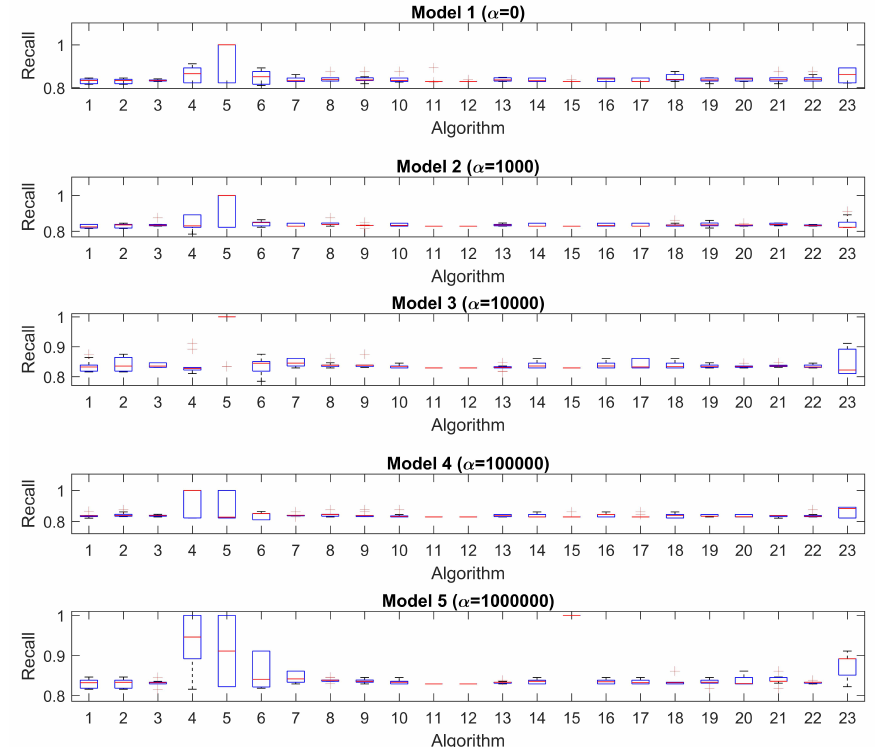
Figure A5. Numerical simulation Assumption 2. Recall of various models after permutations in the numerical values of the mapping. The 23 algorithms are represented in the x -axis, and the accuracy is shown in the y -axis.